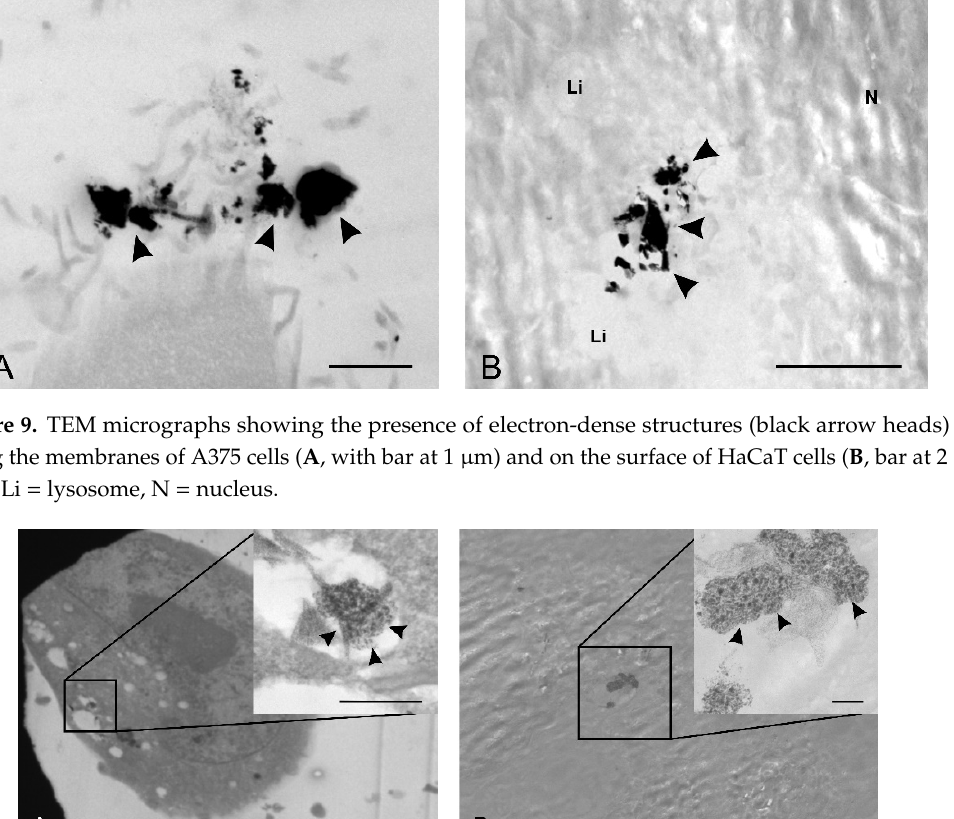
Figure 11. TEM micrographs of the tested cells and EDX spectra confirming the presence of silver in the electron-dense accumulations observed inside A375 cells ( A , bar at 1 µm) and HaCaT cells ( B , bar at 250 nm).